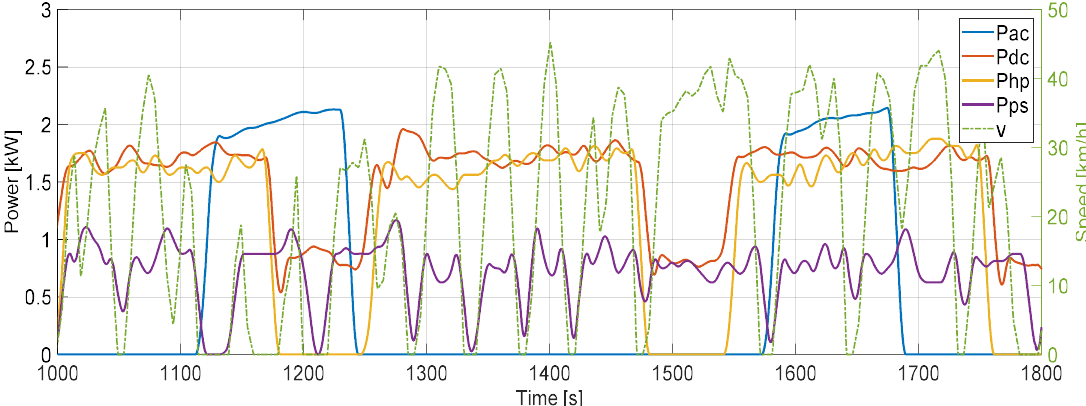
Figure 6. Auxiliary device power of E1 bus as a function of time. The measurement was done on 18 April 2016. The outside temperature on this cycle was 20.5 degrees Celsius on average.